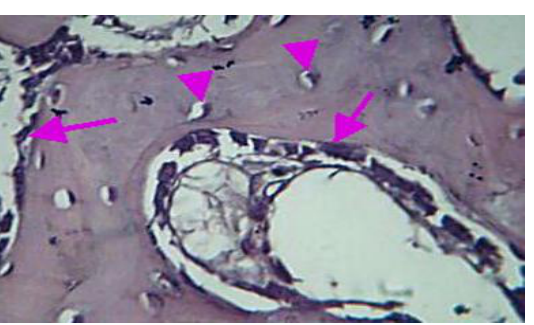
Fig 9: Microscopic Photograph View for the Al O and AgNo Coated Ti Implant after4 2 3 3 Weeks of Implantation. Hand